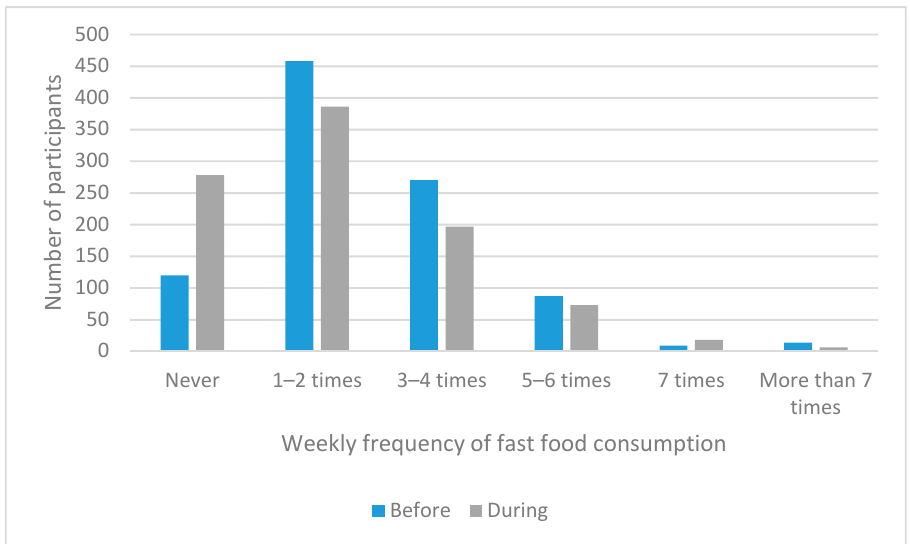
Figure 7 . Weekly fast food consumption frequency prior to and during the pandemic . Figure 7. Weekly fast food consumption frequency prior to and during the pandemic.